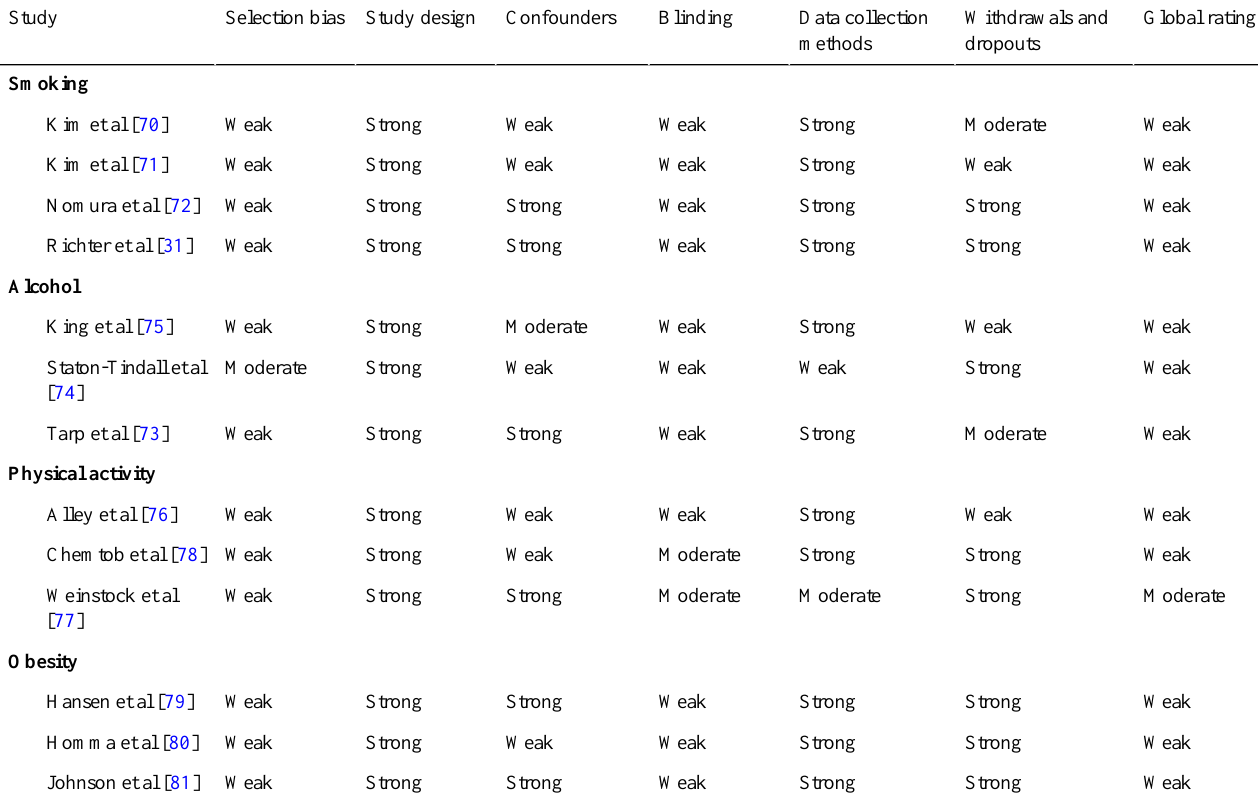
Table 1. Methodological quality assessment of eligible